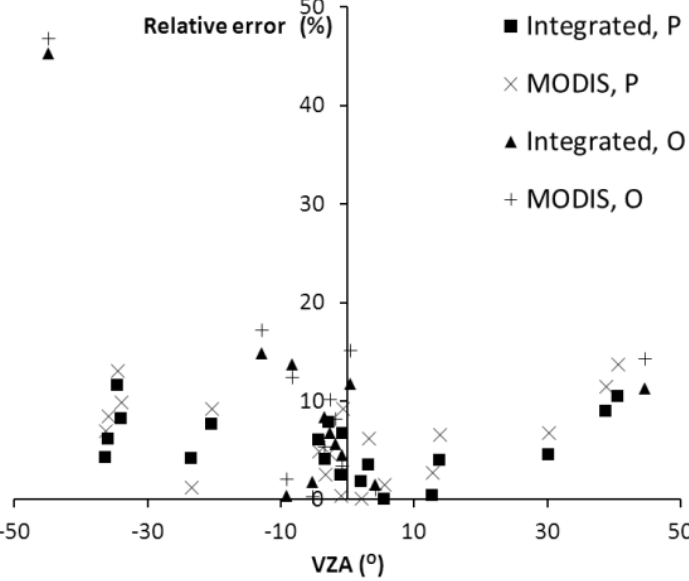
Figure 13. Relative error in the estimation of field albedo as a function of the VZA. The results are grouped according to the direction of the flight with respect to the solar principal plane (P: parallel, O: orthogonal) and the method used for the calculation of the airborne albedo (Integrated or MODIS).